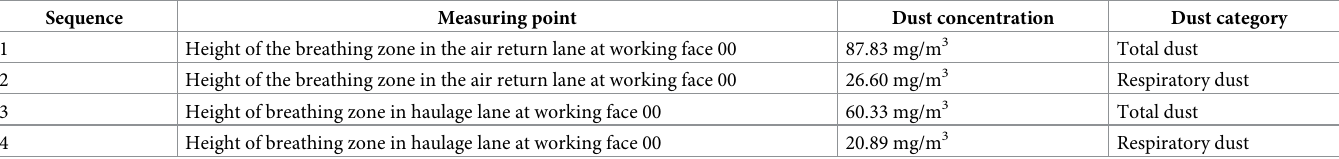
Table 1. Measured dust concentration in the return airway of the 00 working face.